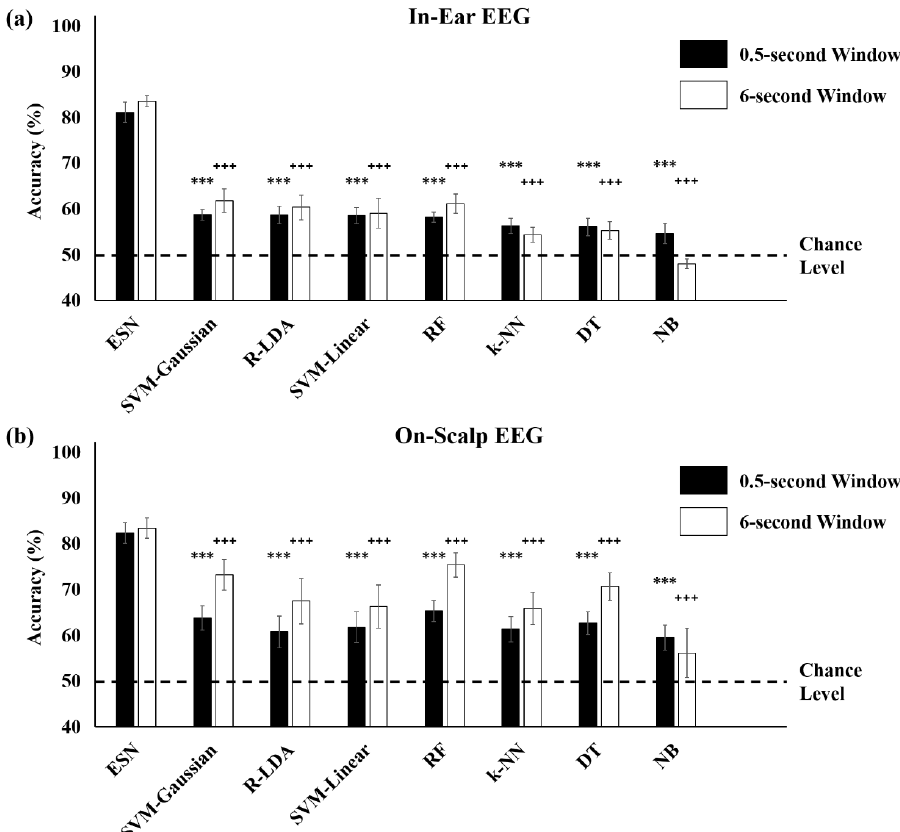
Figure 7. Comparison of classification accuracy between the echo state network (ESN) and conventional machine learning methods and smoothing obtained from the within-subject validation. The ESN classification highly outperformed other conventional machine learning methods in both ( a ) in-ear and ( b ) on-scalp EEGs. The results were sorted in descending order based on the accuracy of nonsmoothed prediction. The dotted line denoted the chancel level (50%). ESN: echo state network, SVM-Gaussian: support vector machine (SVM) with Gaussian kernels, R-LDA: regularized linear discriminant analysis (LDA), SVM-Linear: SVM with linear kernels, RF: random forest, k-NN: k-nearest neighbor algorithm, DT: decision tree, and NB: naïve Bayesian algorithm (*** denotes p < 0.001 when comparing original predicted results without smoothing (0.5 s window) of the ESN and other methods, +++ denotes p < 0.001 when comparing smoothed results using 6 s window of the ESN and other methods, Bonferroni